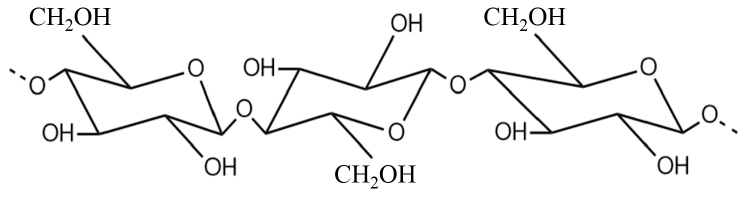
Figure 1. Chemical structure of cellulose.